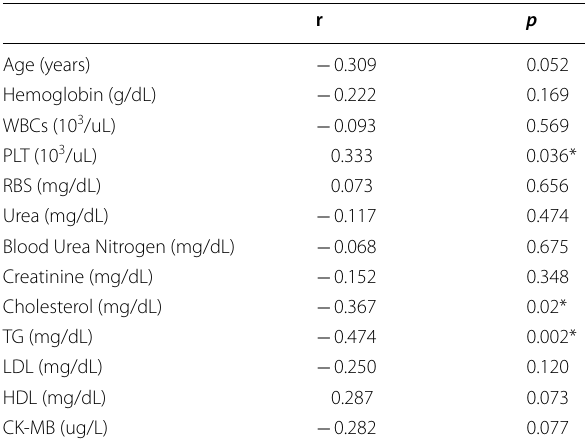
Table 2 Correlations between Sirtuin1 and other studied